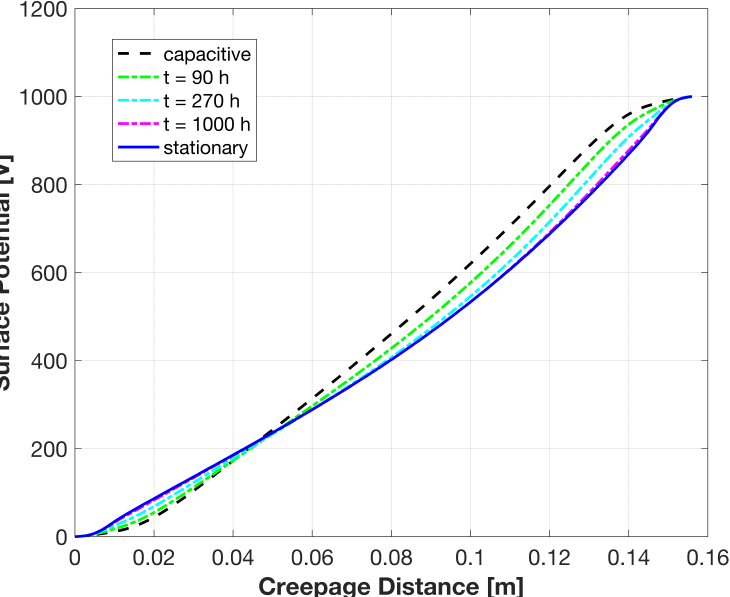
Figure 3. Simulated initial (capacitive) and stationary (resistive) potential along the creepage distance of epoxy insulator surface. The transient behavior at specified instants of time: t = 90 h, t = 270 h and t = 800 h, is also shown.